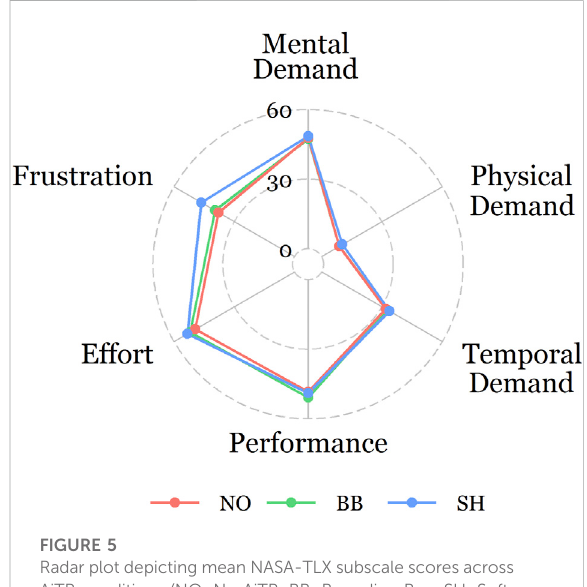
FIGURE 5 Radar plot depicting mean NASA-TLX subscale scores across AiTR conditions (NO: No AiTR, BB: Bounding Box, SH: Soft Highlight). Frustration with SH ( M = 46.4) was higher than with NO ( M = 36.2), p <